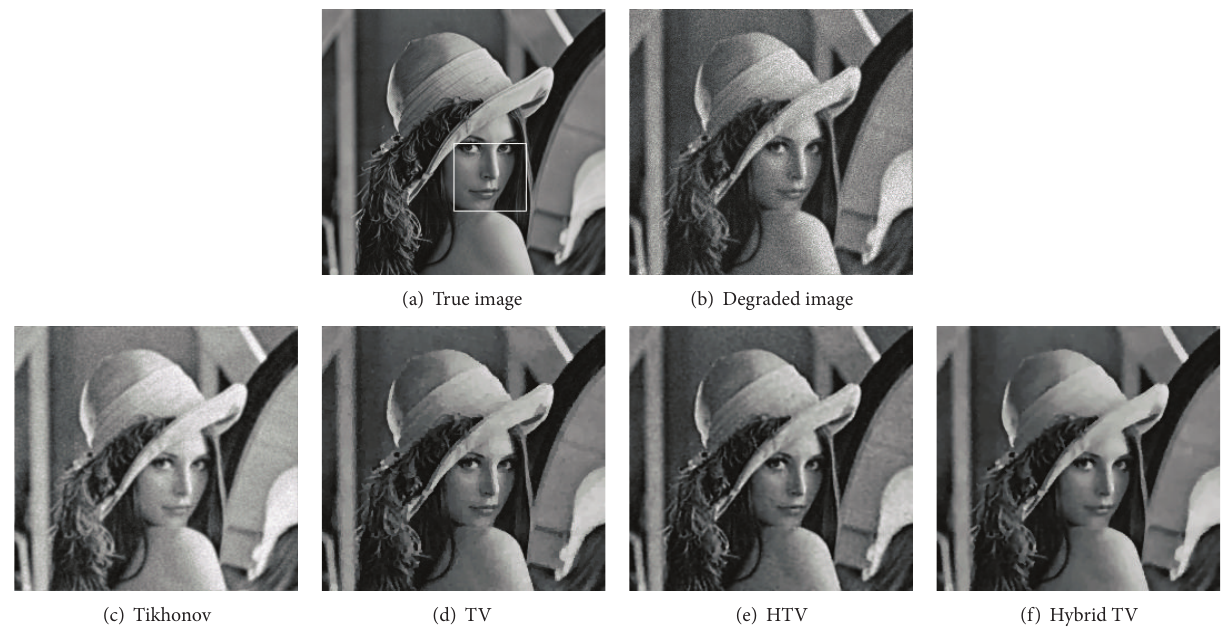
Figure 3: The “Barbara” image is degraded by the Moffat blur and Poisson noise. Table 2: Restoration results with different methods for Example 1, Example 2, and Example